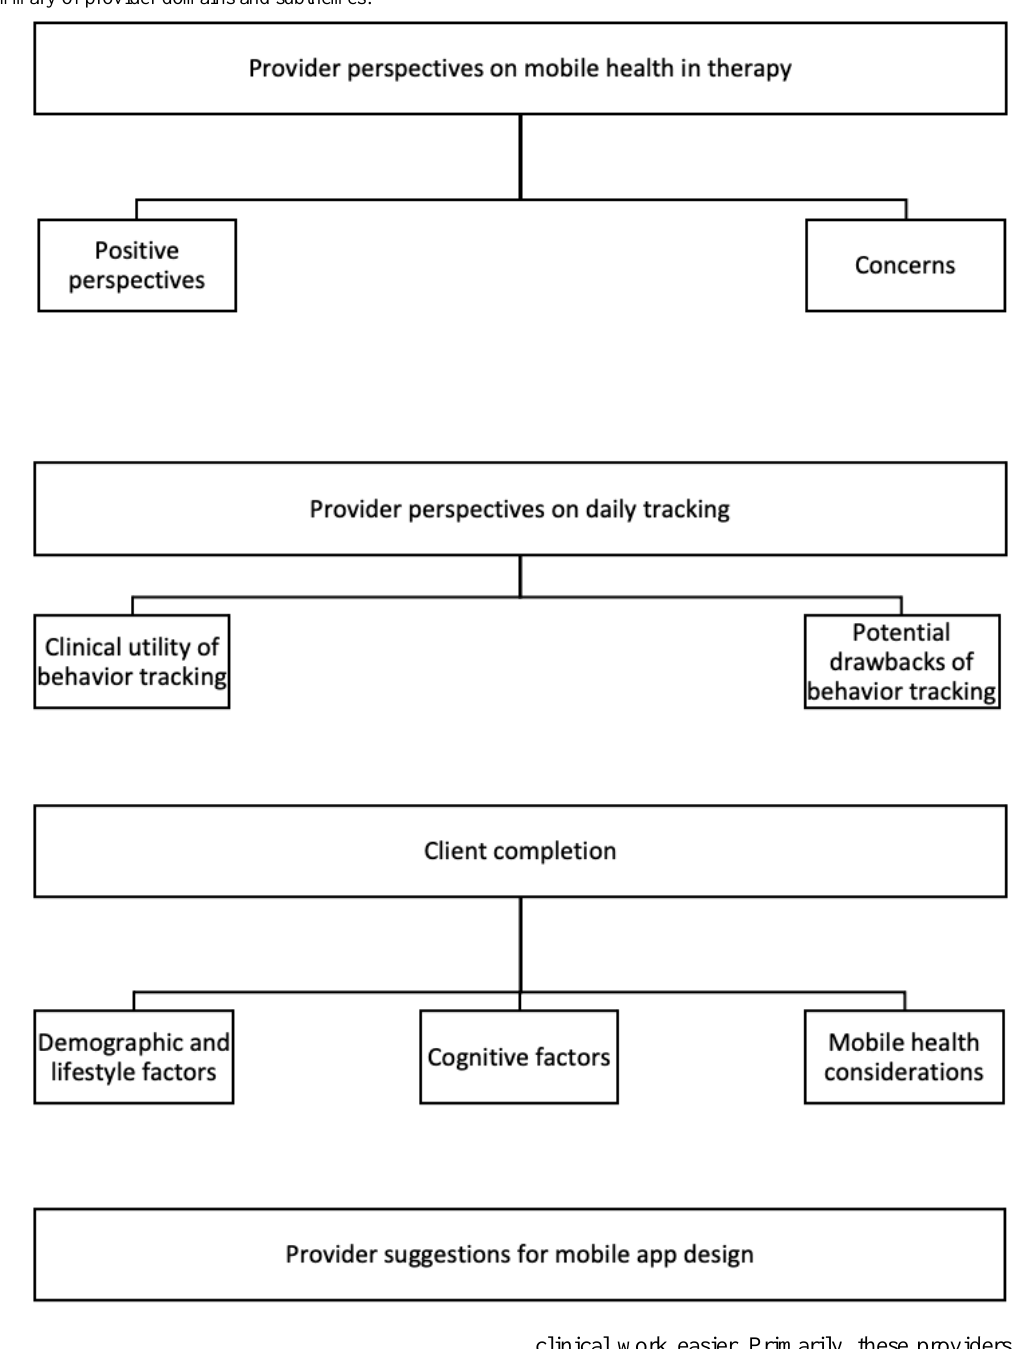
Figure 2. Summary of provider domains and